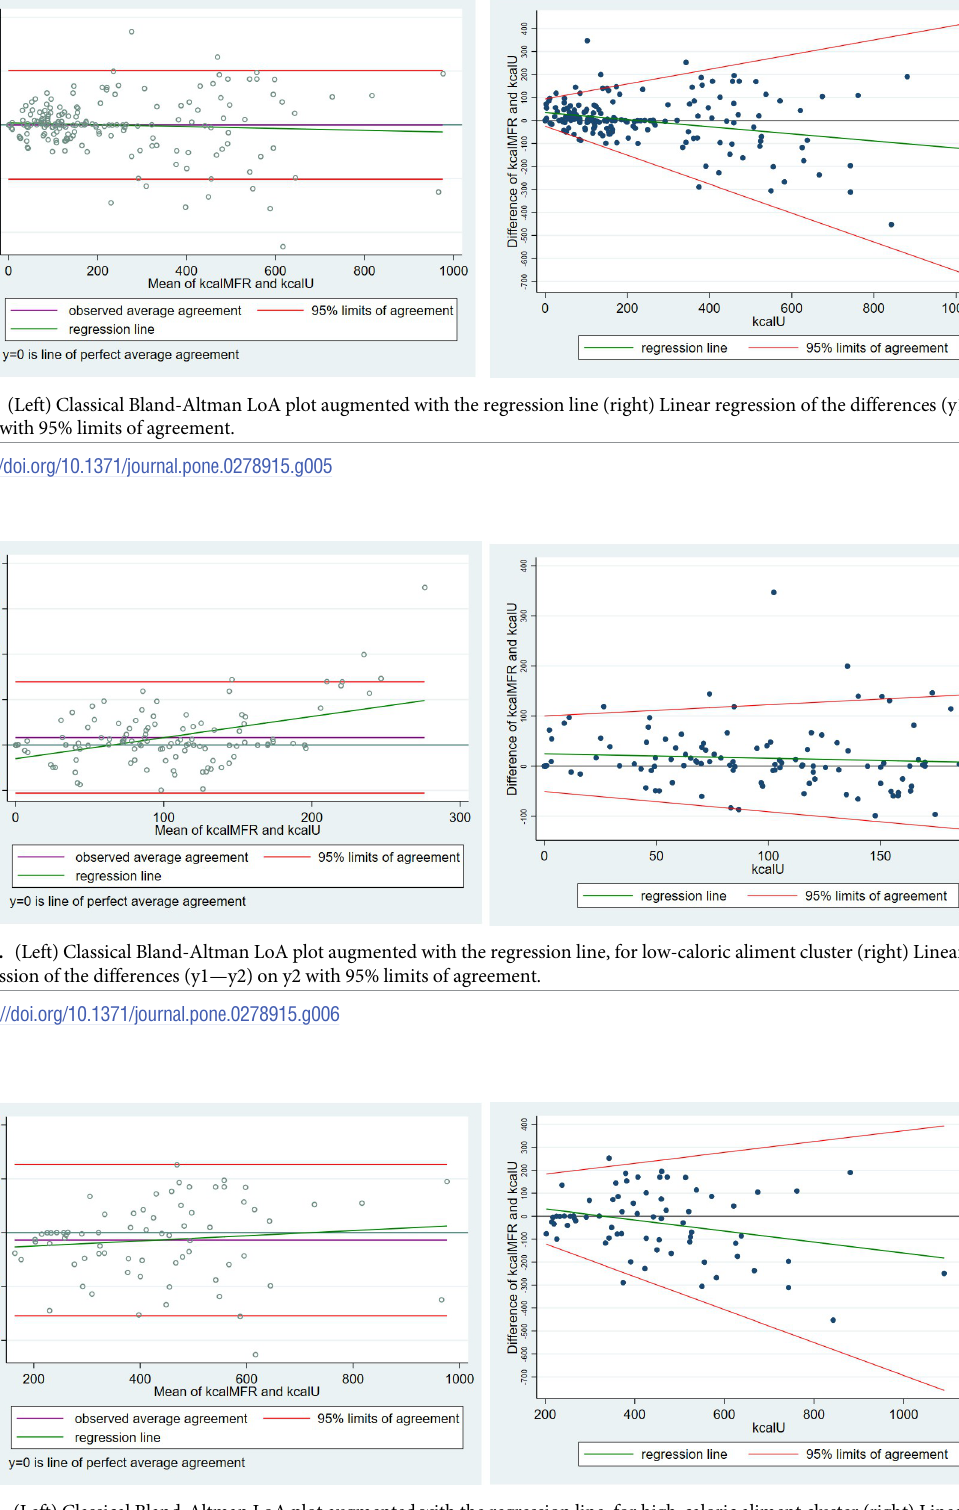
PLOS ONE | https://doi.org/10.1371/journal.pone.0278915 December12,